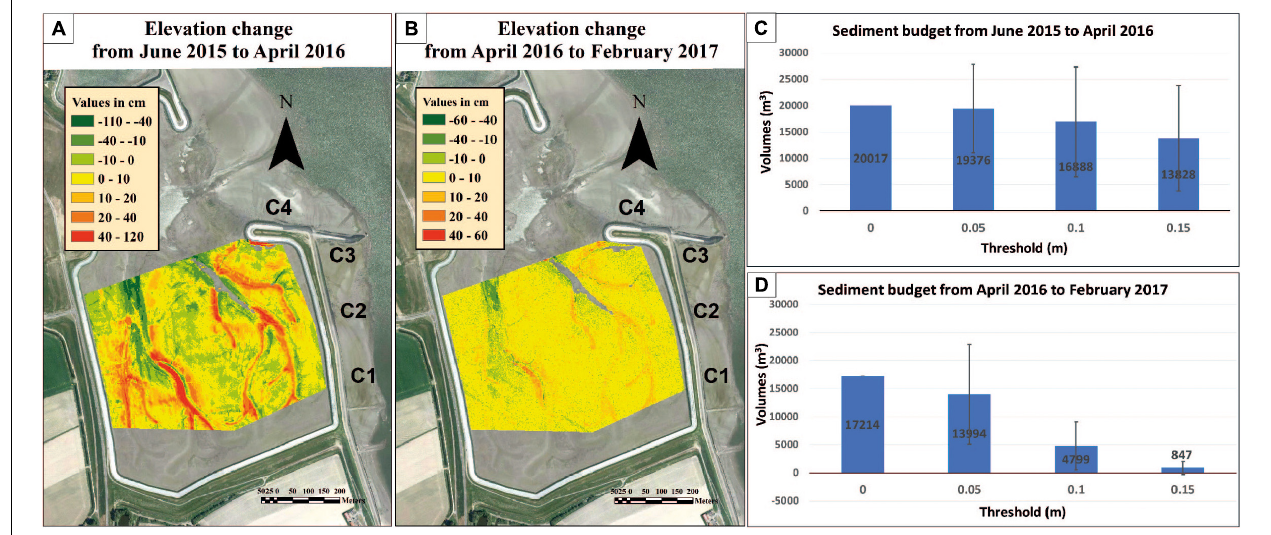
FIGURE 6 | On the left and in the centre (A,B) elevation change computed from June 2015 to April 2016 and from April 2016 to February 2017; on the right (C,D) sedimentary budget computed for both periods considering errors of 0, 0.05, 0.10 and 0.15 m. See the text for further details on survey methodologies.